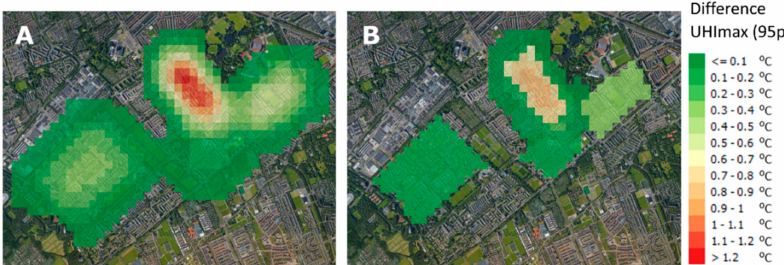
Figure 9. Difference in the modeled 95th percentile of UHI max between ( A ) strategy C (constructing low- and mid-rise buildings) and ( B ) strategy D (constructing high-rise buildings). Both are compared with the current housing for the current climate.